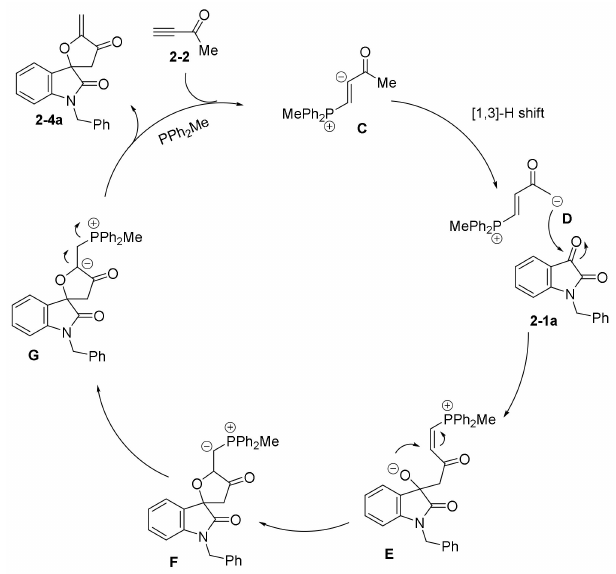
Scheme 5. Plausible mechanism for the formation of furanones ( 2-4